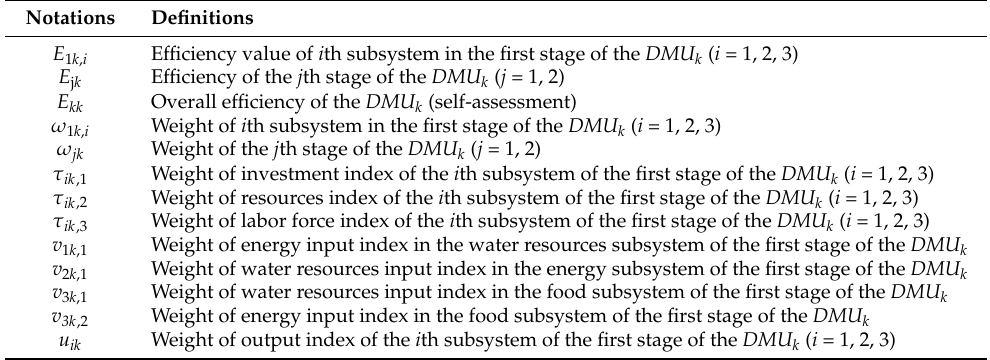
Table 1. The notations and their